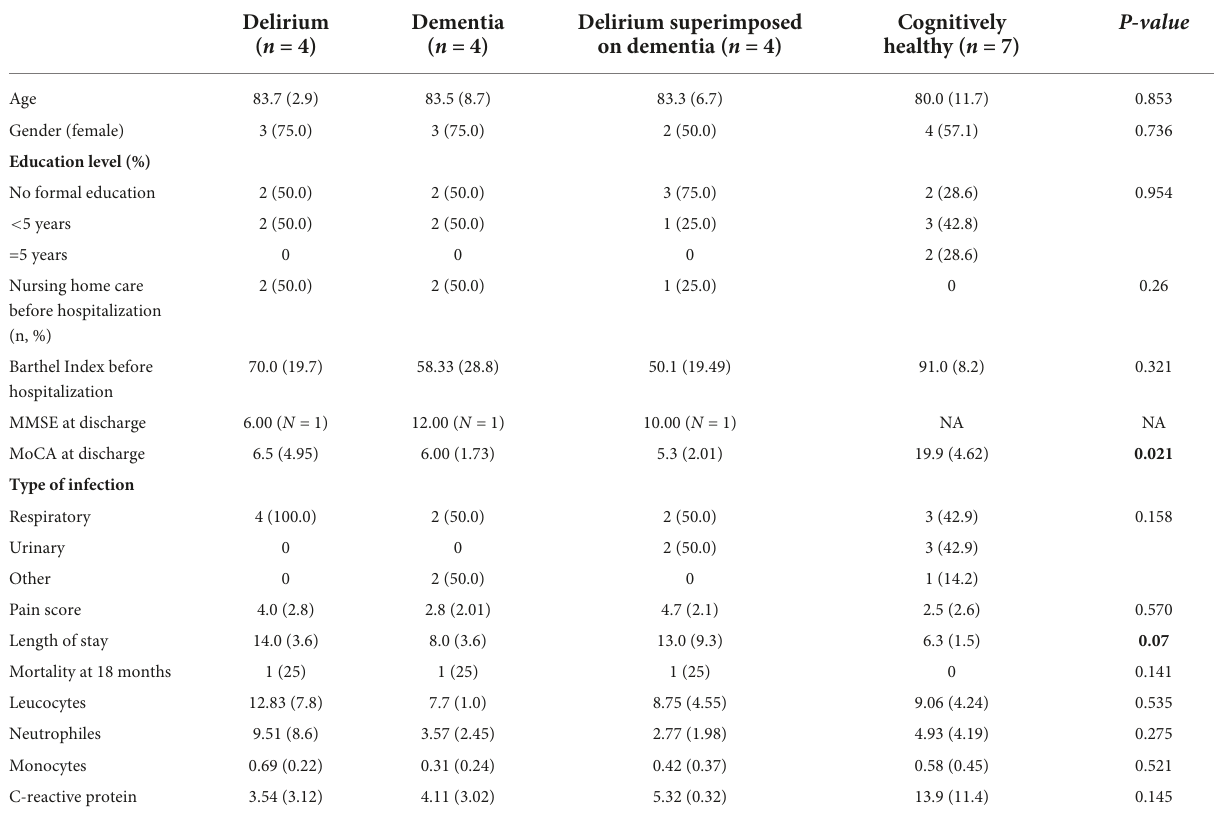
TABLE 1 Socio-demographic and clinical